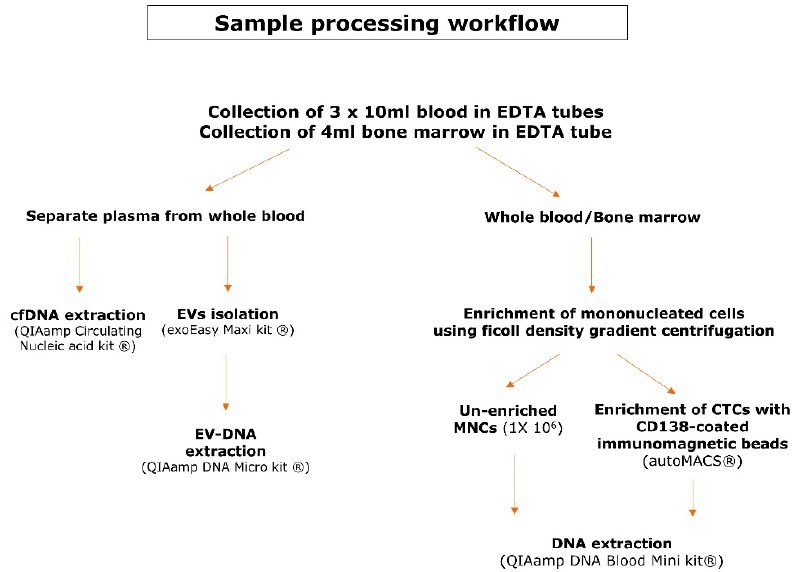
Figure 1. Sample processing workflow. This scheme gives an overview of the pre-analytical steps and the kits used for DNA extraction of the different DNA types .